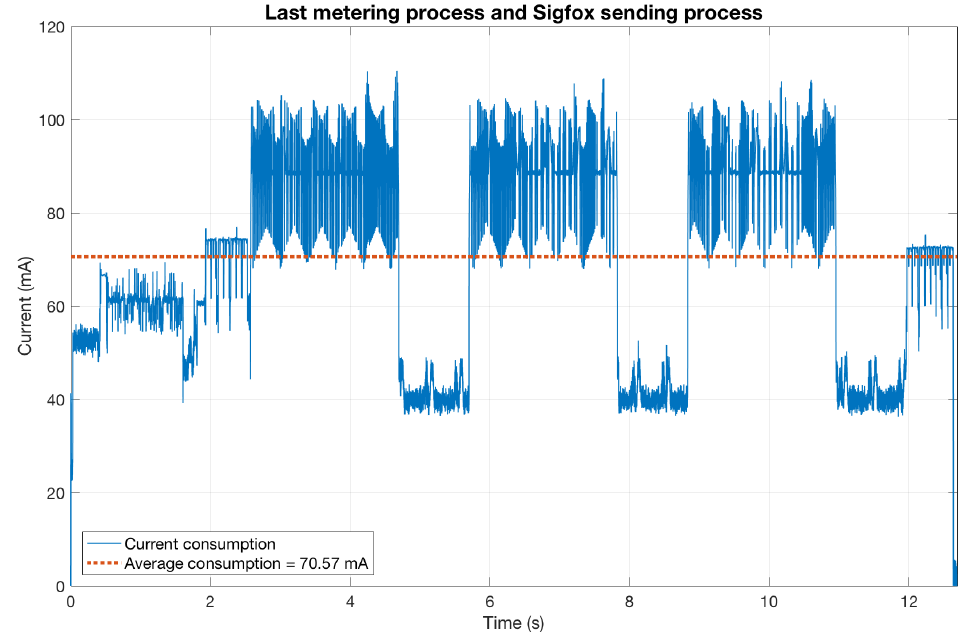
Figure A2. Detailed consumption for the device when a metering process makes the buffer full and the Sigfox message is sent. Notice the three big consumption peaks corresponding to the Sigfox transceiver sending the message thrice—approx. from 2.5 to 12 s.